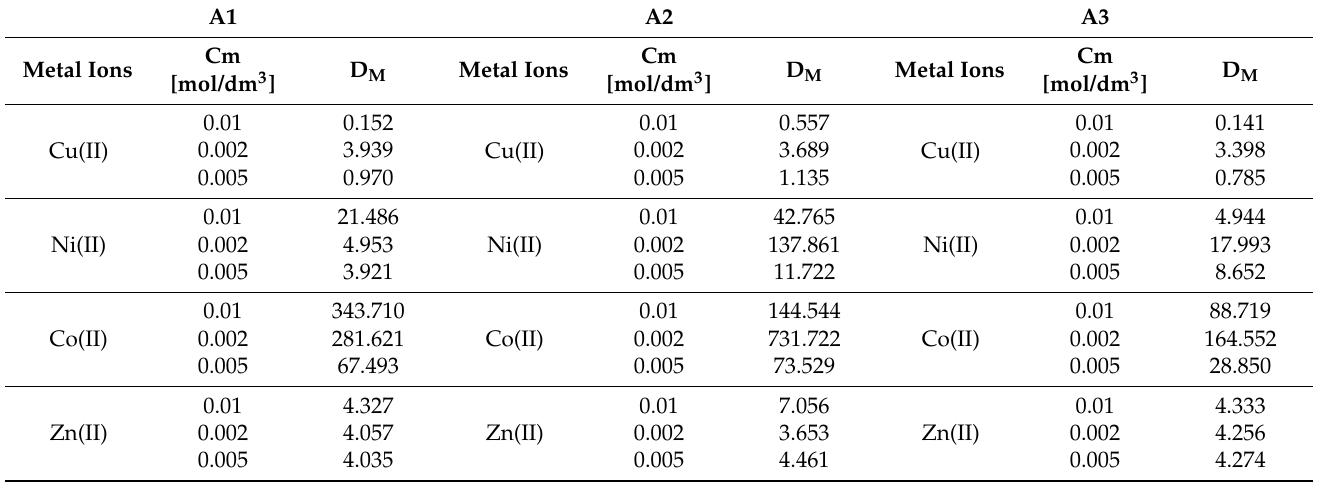
Table 7. The division ratio of metal ions with 2,6-bis((benzoyl-R)amino)pyridine derivatives as extractants. A1 A2 A3 Metal Ions Metal Ions